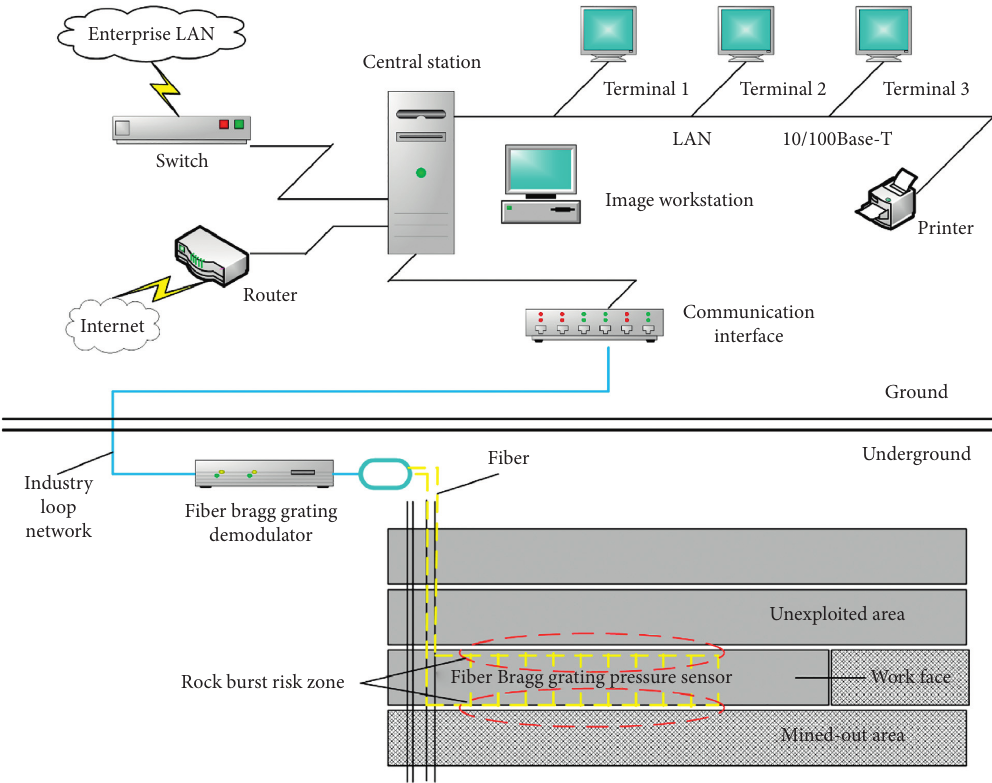
Figure 8: KJ820 stress online monitoring system based on fiber Bragg grating.